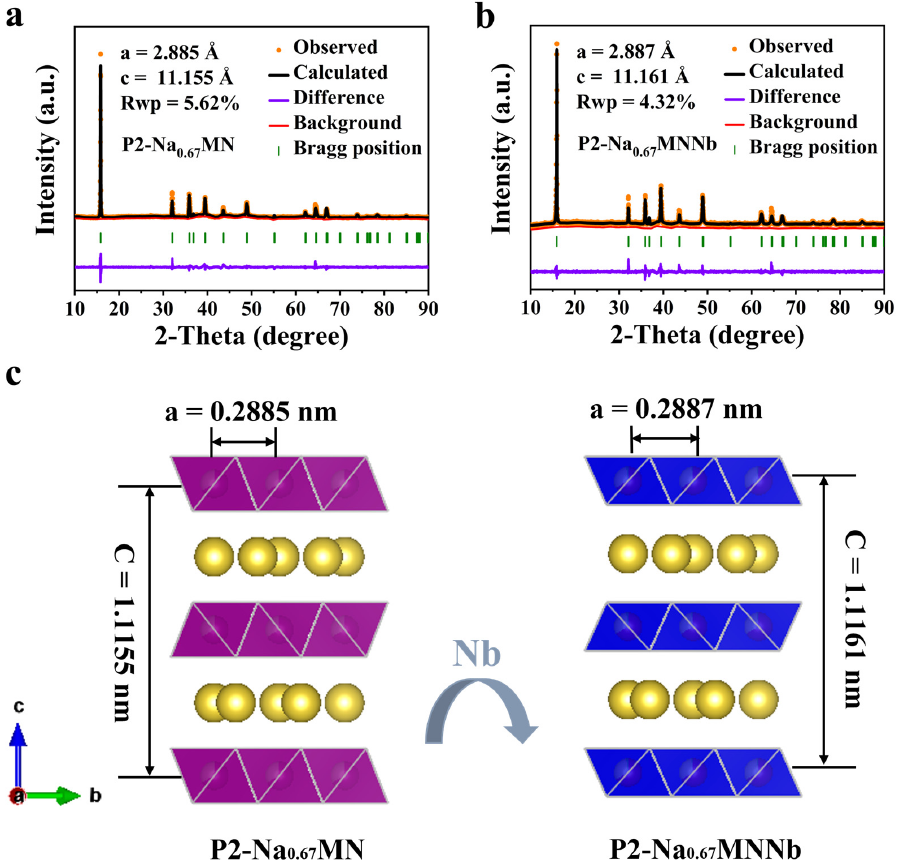
Figure 1. Rietveld refinement plots of ( a ) P2-Na 0.67 MN and ( b ) P2-Na 0.67 MNNb. ( c ) The crystal structures of P2-Na 0.67 MN and P2-Na 0.67 MNNb.